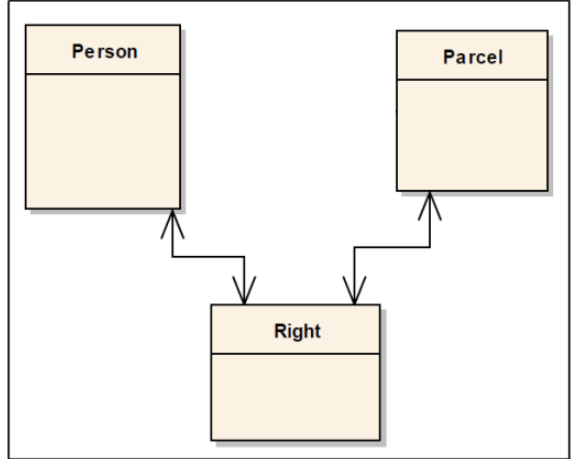
Figure 2. Main components of current cadastral data